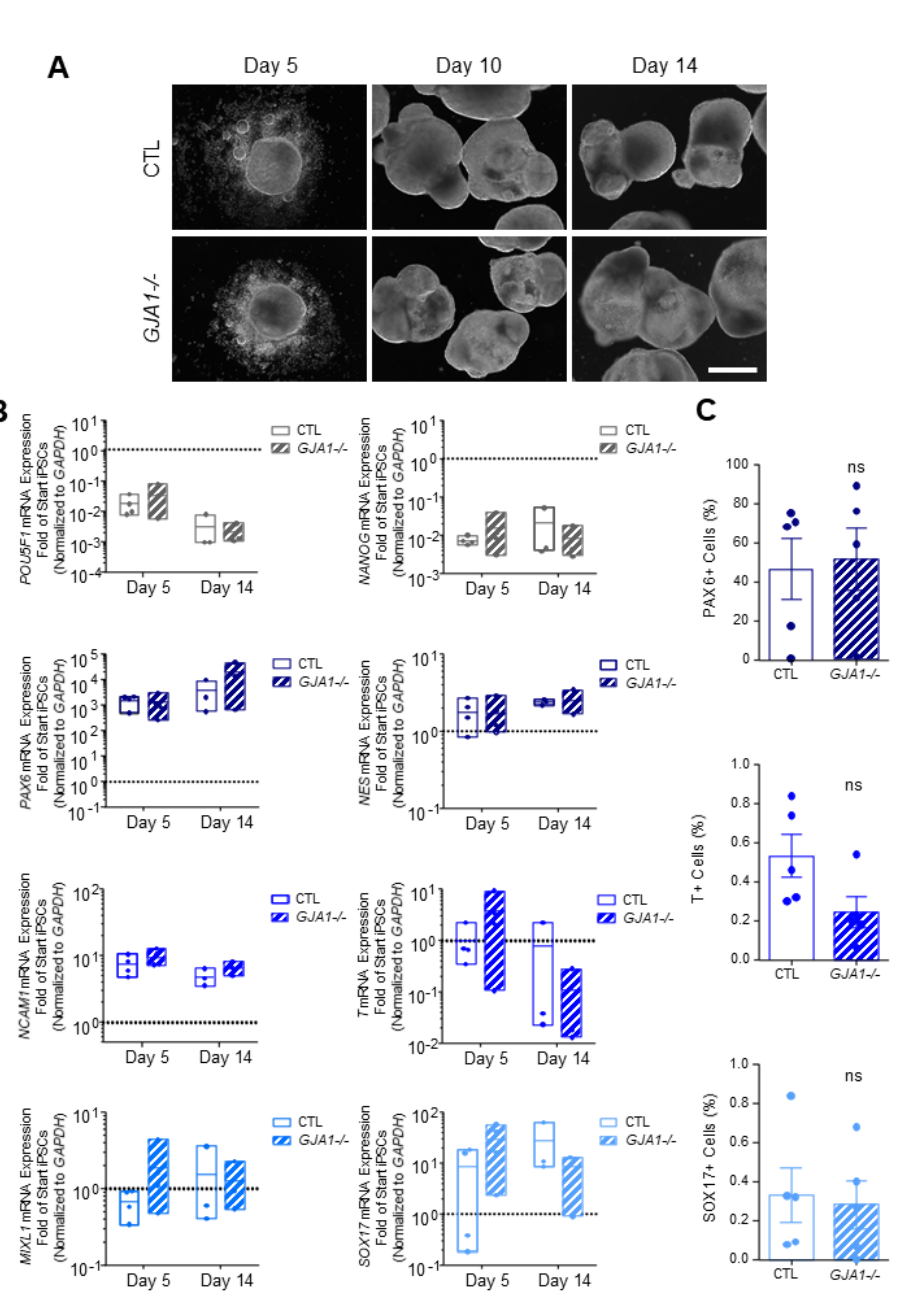
Figure 6. Spontaneously differentiated Cx43 knockout iPSCs form cells of all three germ lineages. ( A ) Phase contrast images of control and GJA1-/- embryoid bodies, scale bar 500 µm. ( B ) qPCR and ( C ) flow cytometric analyses demonstrate comparable spontaneous differentiation capacities of germ lineage populations by control and GJA1-/- embryoid bodies (pluripotency, grey; ectoderm, dark blue; mesoderm, blue; endoderm, light blue). ns: not significant compared to control cells.